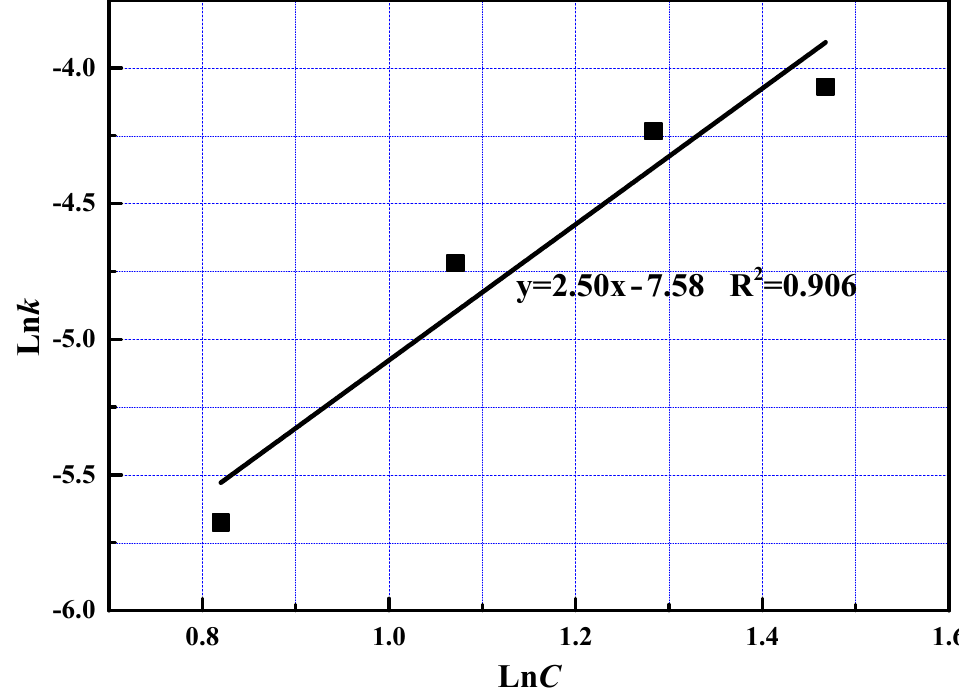
Figure 13. The relationship between lnC and lnk at slow reaction stage.